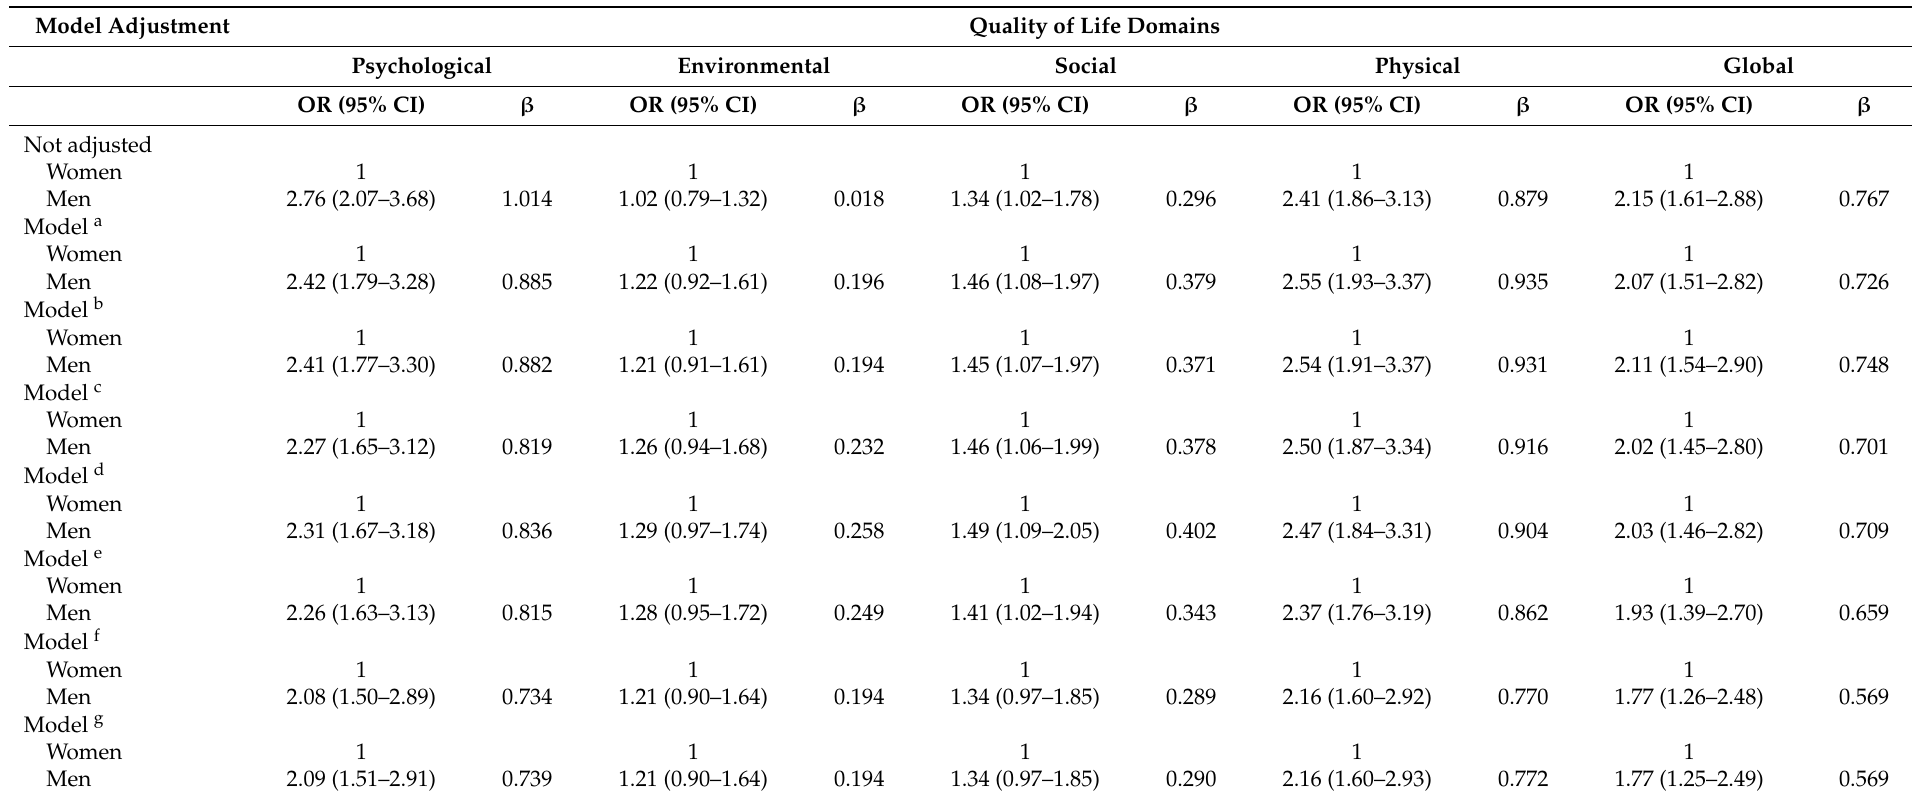
Table 4. Raw and adjusted odds ratios for male and female formal workers regarding quality-of-life scores, stratified by domains and adjusted using the ordinal logistic regression model for socio-demographic, economic, behavioral, and clinical